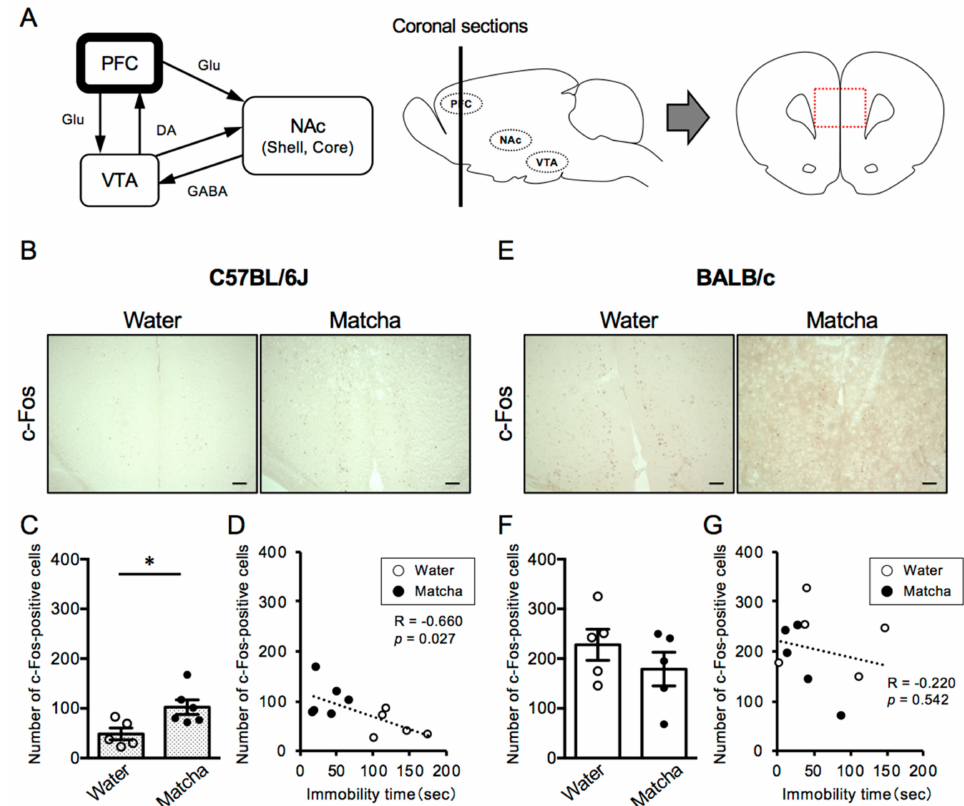
Figure 4. Effects of Matcha tea powder on the neural activity in the PFC region in C57BL/6J and BALB/c mice. ( A ) A schematic view of the PFC-NAc-VTA circuit (dopaminergic system). Dotted lines in red indicate the area of interest for image analysis of the number of c-Fos-positive cells in the PFC region. ( B , E ) Representative photographs showing immunohistochemistry on c-Fos in the PFC region 2 h after Matcha tea powder administration (100 mg/kg, p.o.). ( C , F ) The quantification of the number of c-Fos-positive cells is shown. The results are expressed as the means ± SEM. n = 5–6 animals ( C ) and n = 5 animals ( F ), respectively. The data were analyzed by the unpaired t -test. * p < 0.05. ( D , G ) The correlation between immobility time in the TST and the number of c-Fos-positive cells in the PFC region is shown. Scale bars = 100 µ m. DA; dopamine, GABA; γ -aminobutyric acid, Glu;